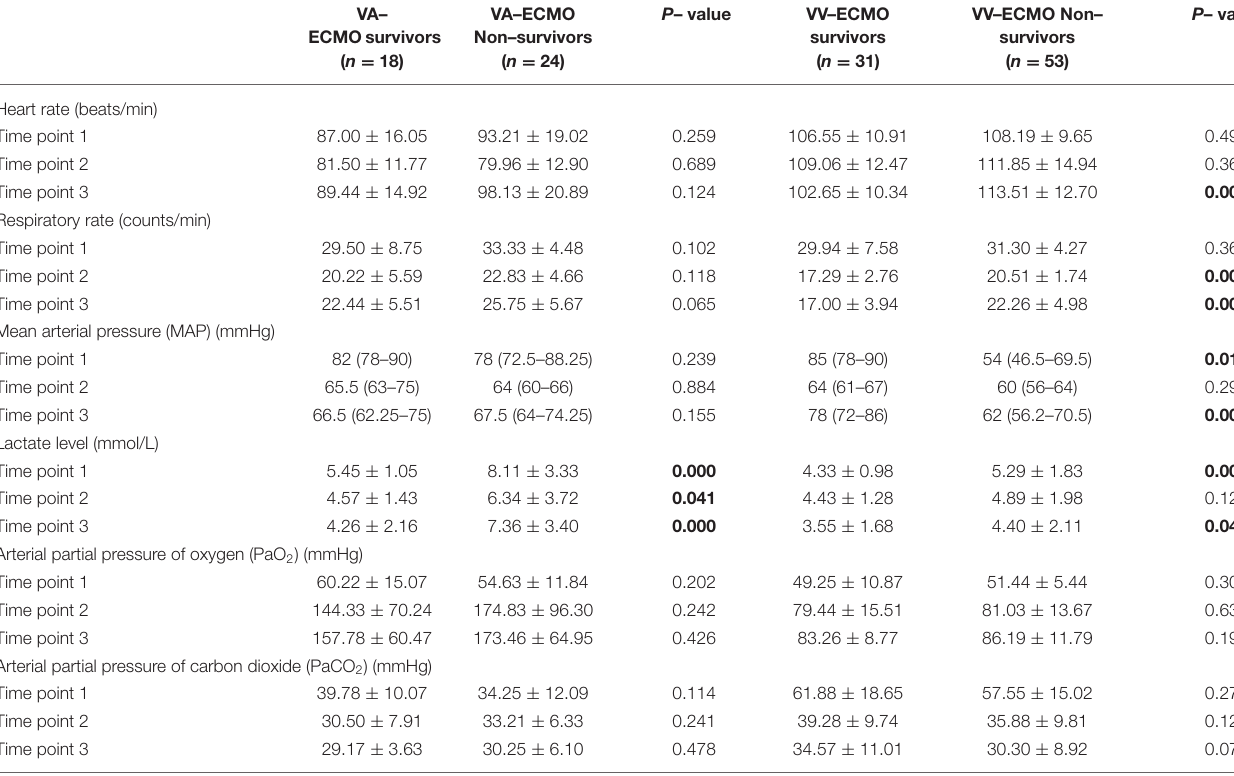
TABLE 4 | Comparison of the indexes of the survivors and non-survivors of